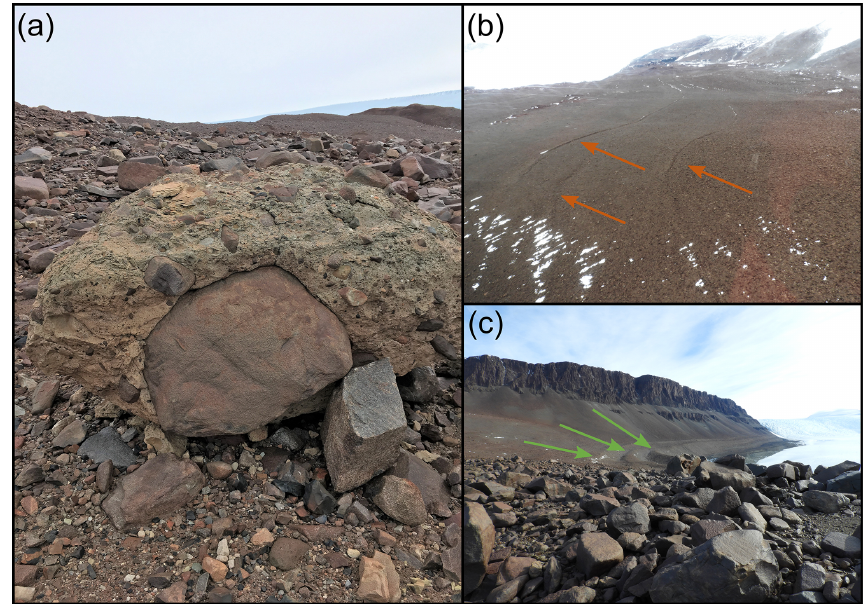
Figure 2. The Sirius Group was documented at Roberts Massif near the RM2-8 sampling location (a) . Small moraines were observed at Roberts Massif (b) and large moraines at Bennett Platform (c)